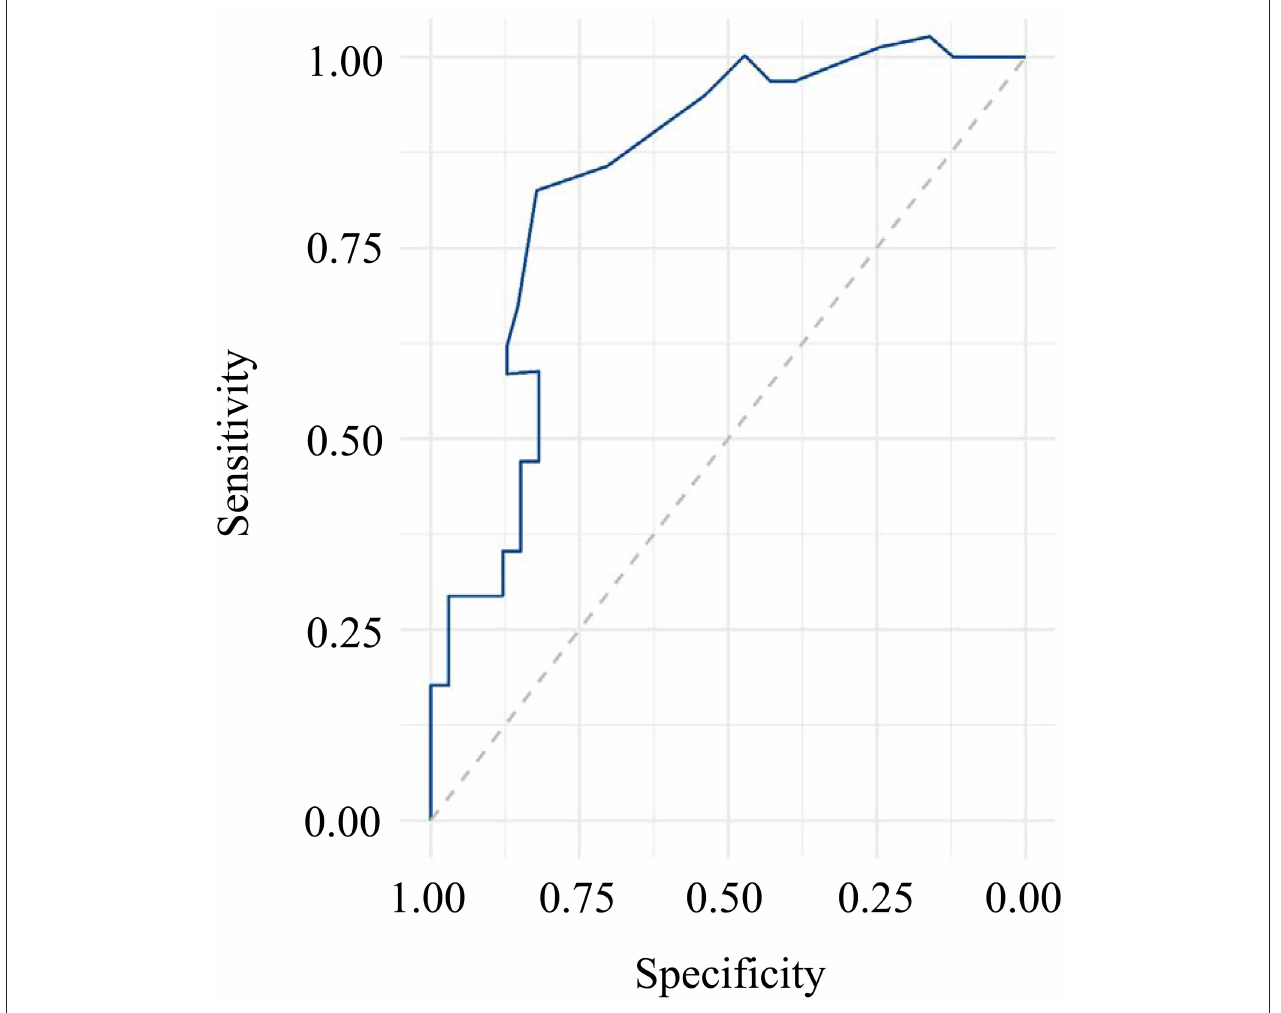
FIGURE 2 | ROC curve analysis for serum irisin levels in all